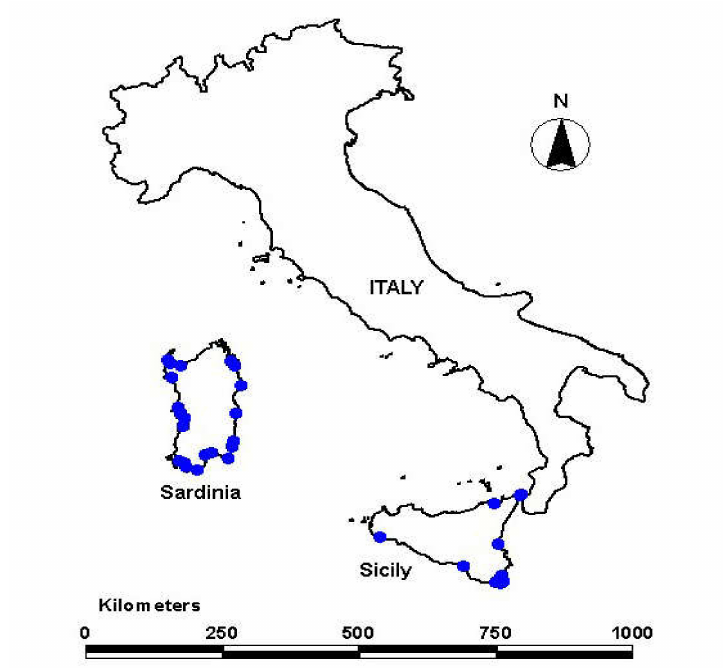
Figure 1. The 38 wetlands (blue dots) under